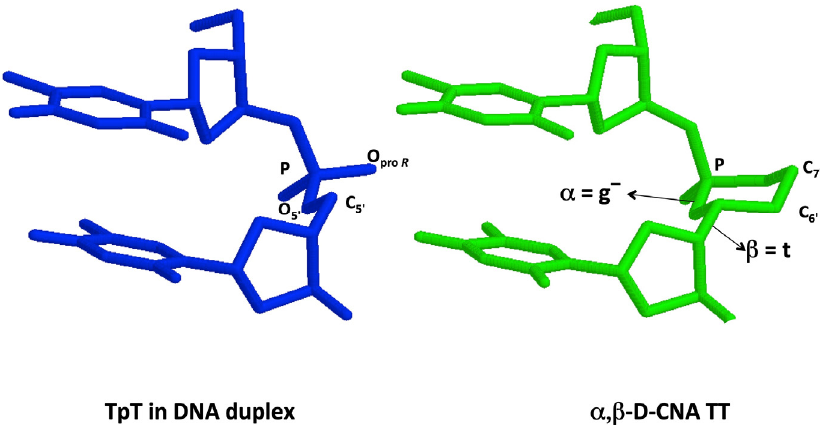
Figure 5. Initial hypothesis for the sugar/phosphate backbone conformational control by construction of a 1,3,2-dioxaphosphorinane moiety.